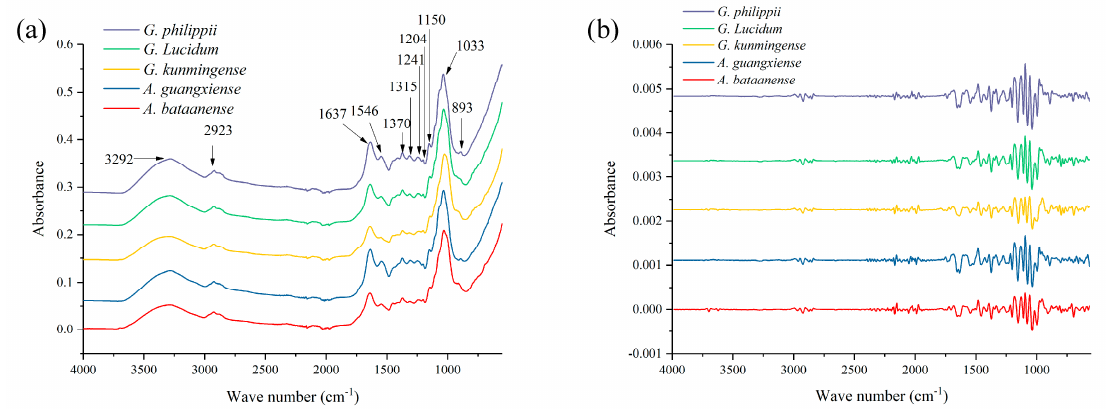
Figure 1. The average spectra of ATR-FTIR of five species of Lingzhi samples. ( a ) Raw ATR-FTIR spectra; ( b ) pretreated SD of the ATR-FTIR spectra.